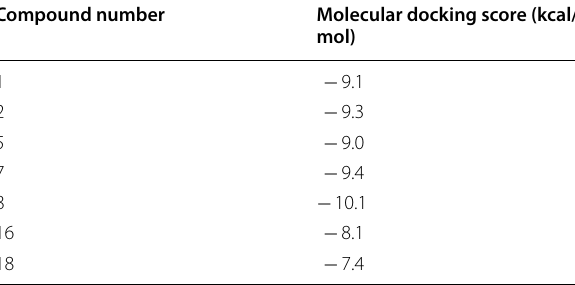
Table 1 Molecular docking result of the designed